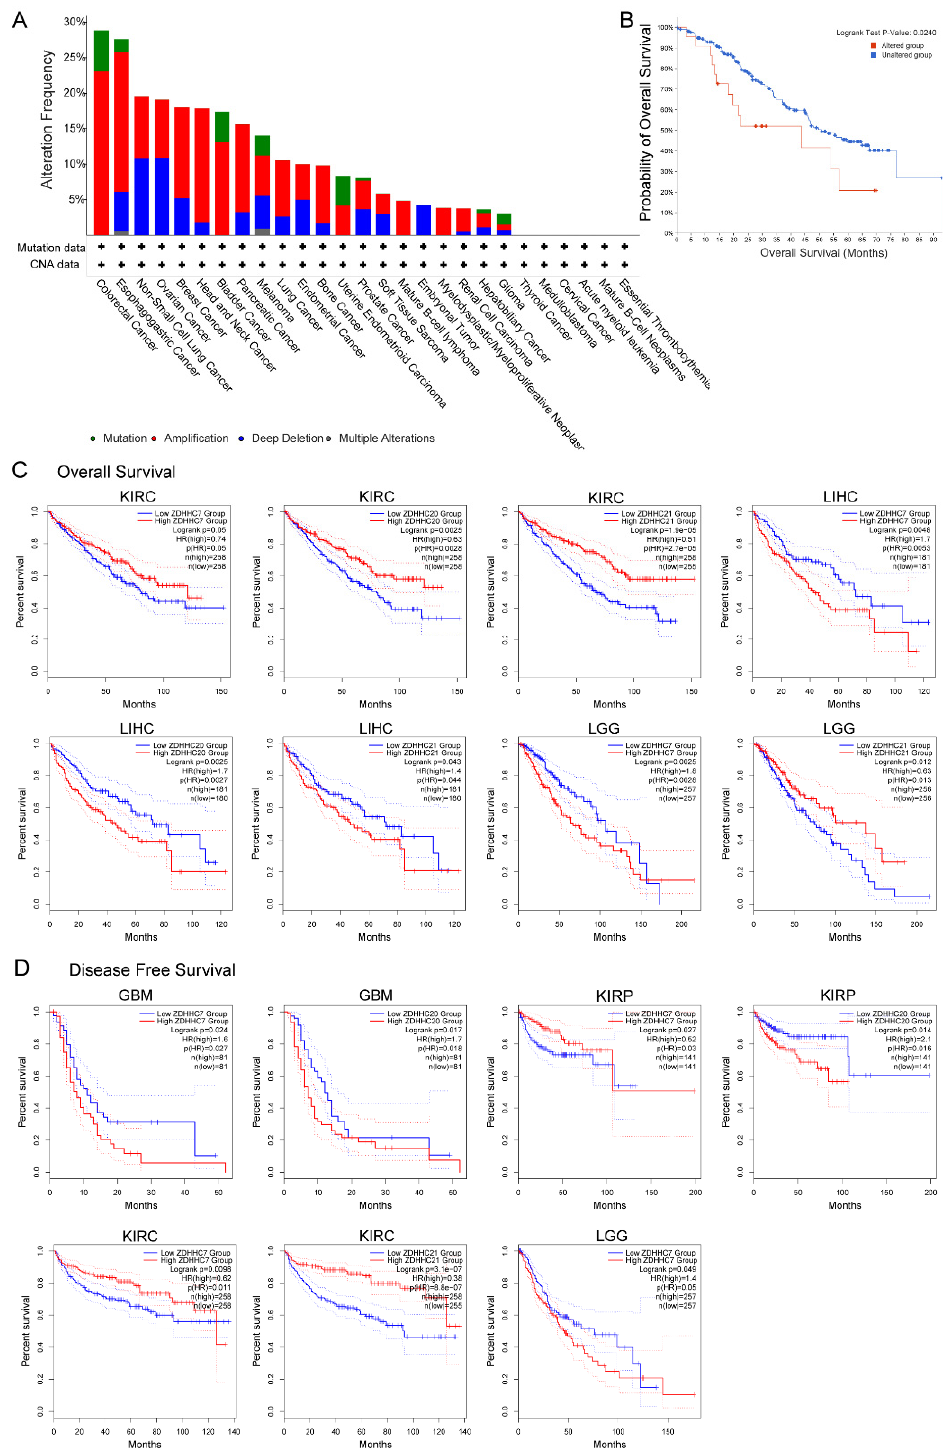
Figure 4. Genome alterations and Kaplan–Meier survival curve of ZDHHC7/20/21 in human cancers. ( A ) Barplots showing the genetic alterations of ZDHHC7/20/21 across cancer types. ( B ) Kaplan–Meier survival analysis of cancer patients in the ZDHHC7/20/21 altered and unaltered groups. ( C ) The survival curve of ZDHHC7 for OS in KIRC, LGG, and LIHC. ( D ) The survival curve of ZDHHC7 for DFS in GBM, KIRP, KIRC, and LGG.